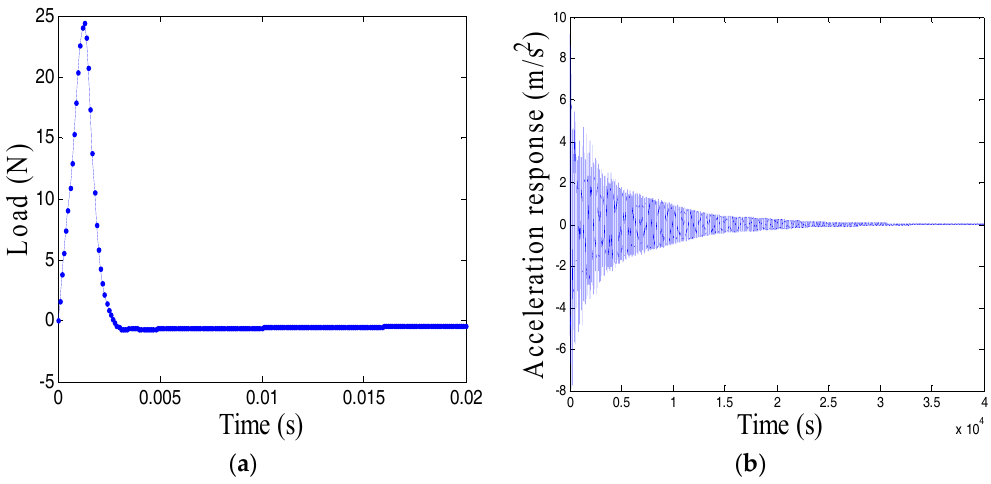
Figure 15. Measured test results. ( a ) Measured excitation; ( b ) Acceleration response.